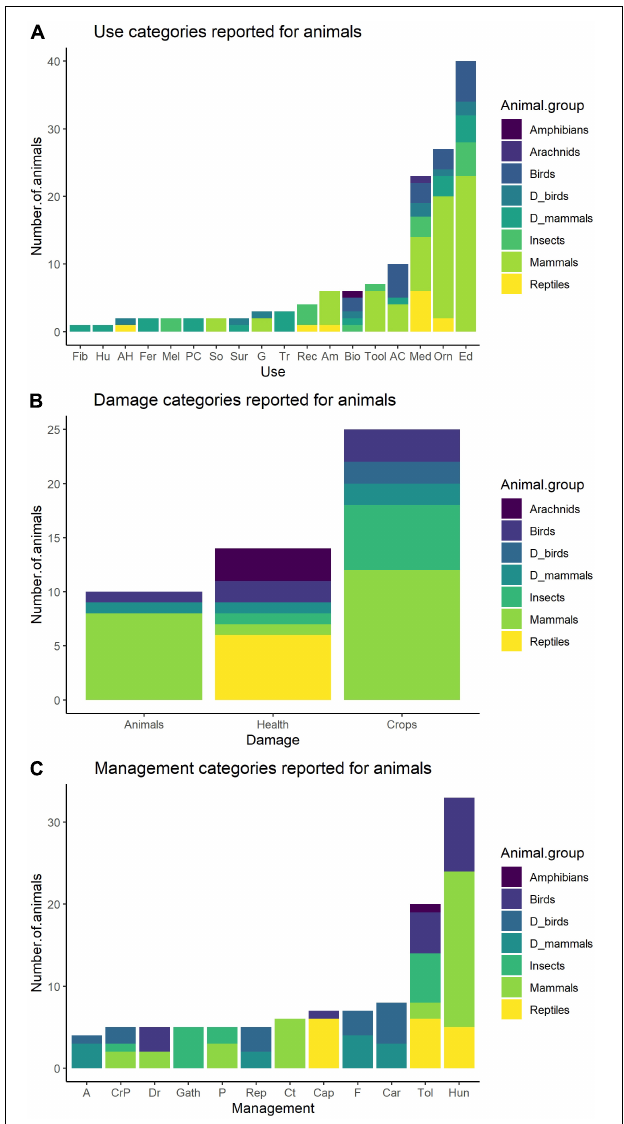
FIGURE 4 | Distribution of use, conflict, and management categories for animal group. (A) Use categories: Edible (Ed), Ornamental/exhibition (Orn), and Medicinal (Med) categories. Those with more reports were mainly represented by wild animal items. However, seven categories were only reported for domestic animals. AC, animal companion; Bio, bioindicator; Am, amulet; Rec, recreational; Tr, traction/transport; G, gift/offering; Sur, surveillance; So, souvenir; PC, pest control; Mel, honey production; Fer, fertiliser; AH, animal health; Hu, aid in hunting; Fib, Fibers. (B) Damage categories: both wild and domestic animals were related to damage. (C) Management categories. Tol, Tolerance; P, poison; CrP, crop protection; Gath, gathering; Cap, capture (obtaining snakes and birds, but not killing them to get them); Ct, captivity (keeping the animal alive at home); Hun, hunting; Dr, drive away; Rep, reproduction; Car, cares; F, feeding; A, agreements. Elaborated in R software (Rudis et al., 2020; Garnier et al., 2021; Wickham et al., 2021).